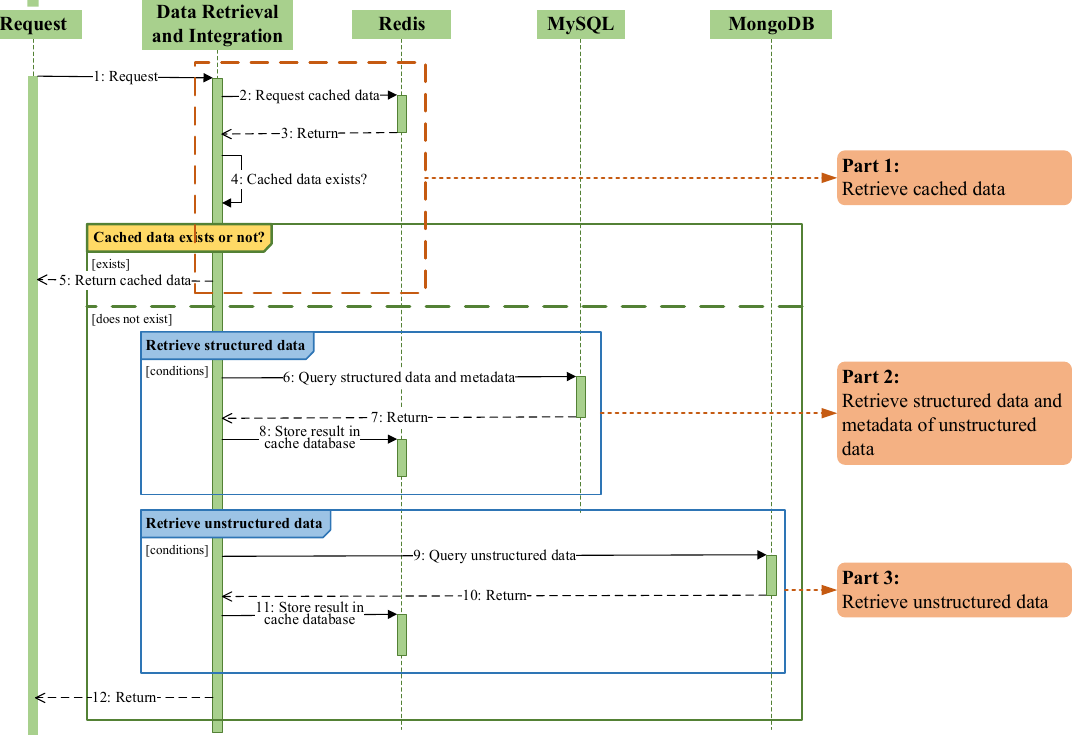
Figure 5. Hybrid SQL/NoSQL access flow. [ conditions ] represents the parameters for retrieving different data from MySQL or MongoDB.